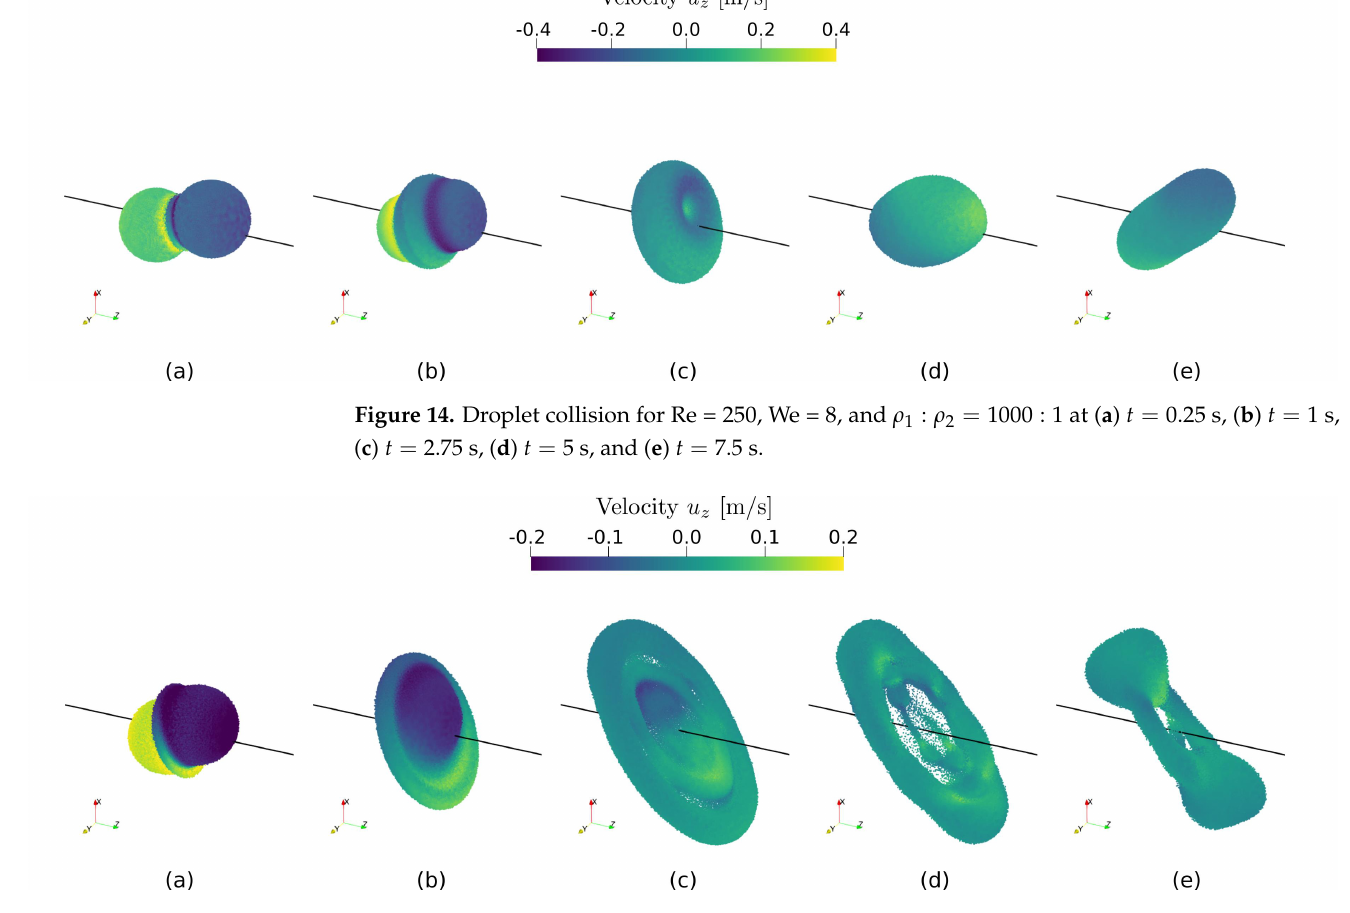
Figure 15. Droplet collision for Re = 550, We = 180, and ρ 1 : ρ 2 = 1000 : 1 at ( a ) t = 1 s, ( b ) t = 3.25 s, ( c ) t = 11.25 s, ( d ) t = 15 s, and ( e ) t = 22.5